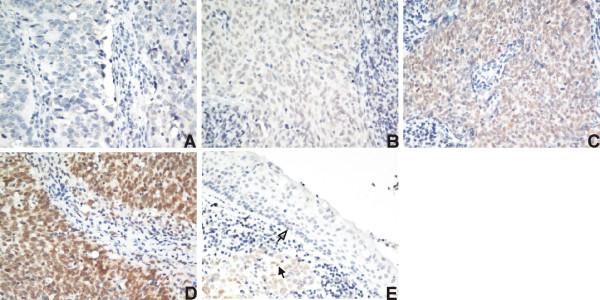
Immunohistochemical analysis of MTA1 protein expression in nasopharyngeal carcinoma tissues. MTA1 protein expression was mainly localized within the nucleus. (A) Negative staining (400×); (B) weak staining: light yellow (400×); (C) moderate staining: yellow brown (400×); (D) strong staining: brown (400×); (E) MTA1 protein expression was upregulated in the nasopharyngeal carcinoma tissue (solid arrow) compared to the adjacent noncancerous epithelial cells (hollow arrow).